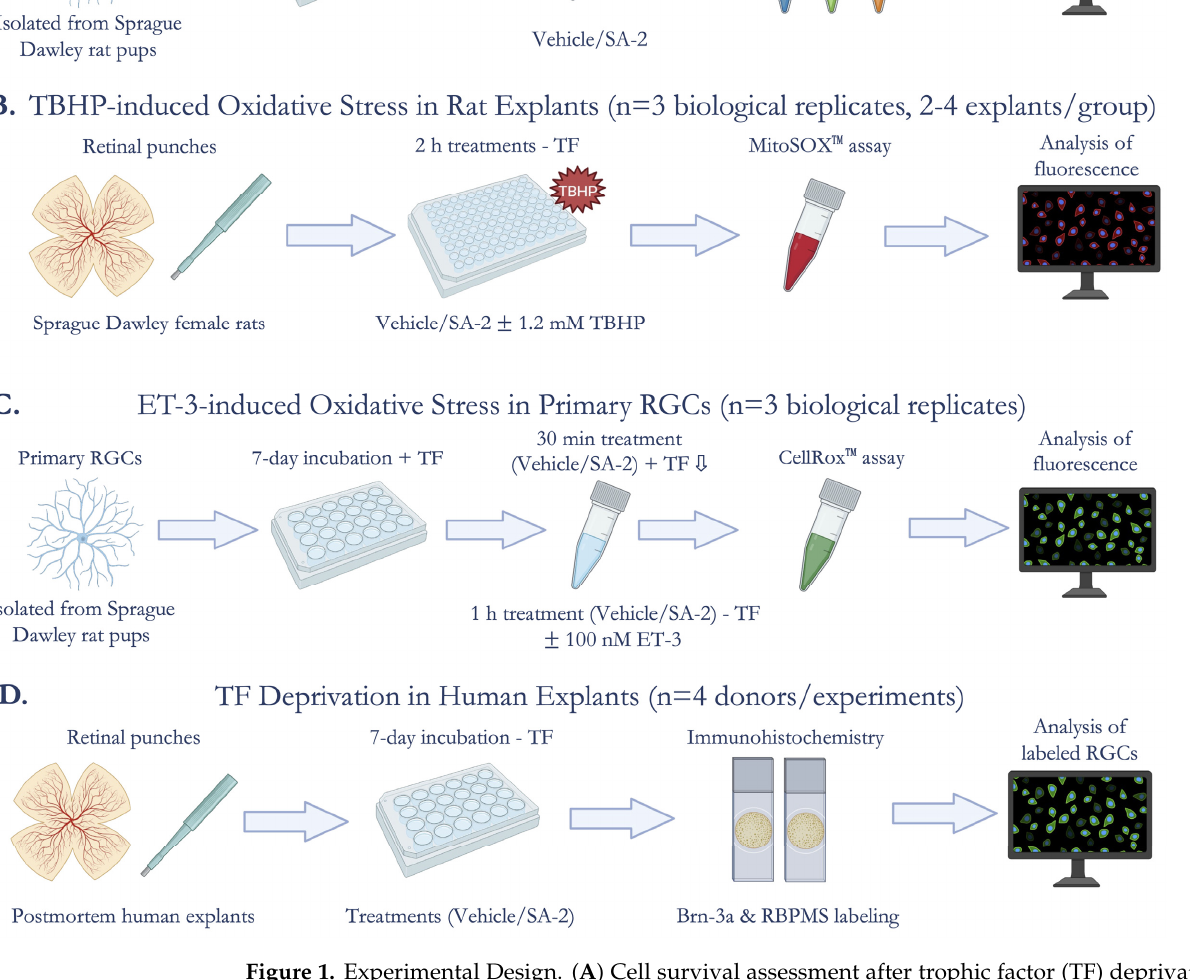
Figure 1. Experimental Design. ( A ) Cell survival assessment after trophic factor (TF) deprivation in primary rat retinal ganglion cells (RGCs) (n = 3 biological replicates) using Image-iT™ LIVE Green Caspase-3 and -7 Detection Kit; ( B ) Measurement of mitochondrial superoxides produced by tert -Butyl hydroperoxide (TBHP)-induced oxidative stress in ex vivo rat retinal explants (n = 3 biolog- ical replicates, 2–4 explants per group) using MitoSOX™ Red Mitochondrial Superoxide Indicator; ( C ) Quantification of reactive oxygen species (ROS) in endothelin-3 (ET-3)-induced oxidative stress in primary rat RGCs (n = 3 biological replicates) using CellROX™ Green Reagent; ( D ) Assessment of cell survival after TF deprivation in ex vivo human retinal explants (n = 4 donors/experiments) by immunostaining for Brn-3a and RBPMS (RGC